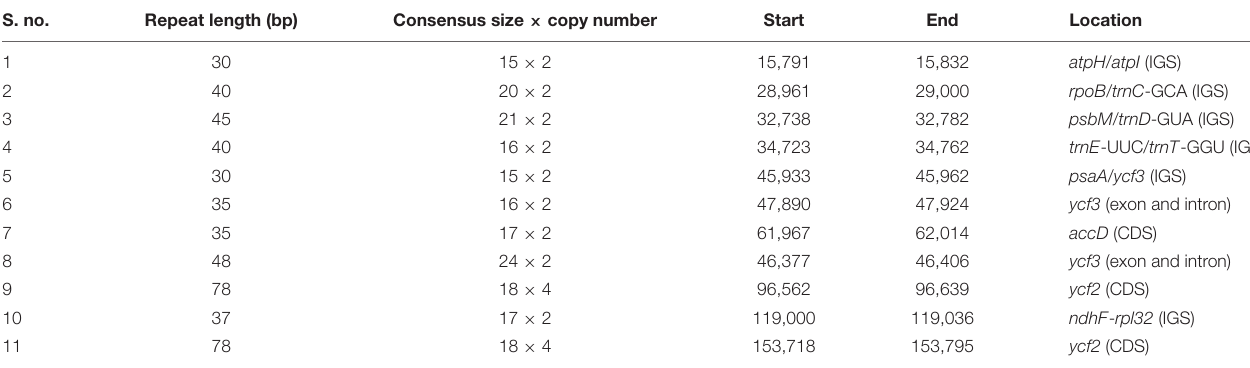
TABLE 5 | Distribution of tandem repeats in Ampelopsis chloroplast genome. S.